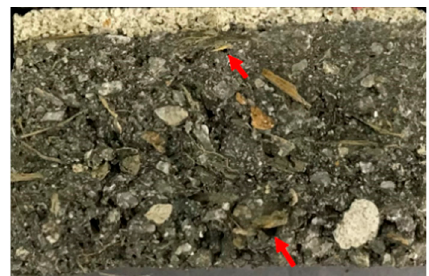
Figure 6. Voids between the fiber and the matrix (cross section).